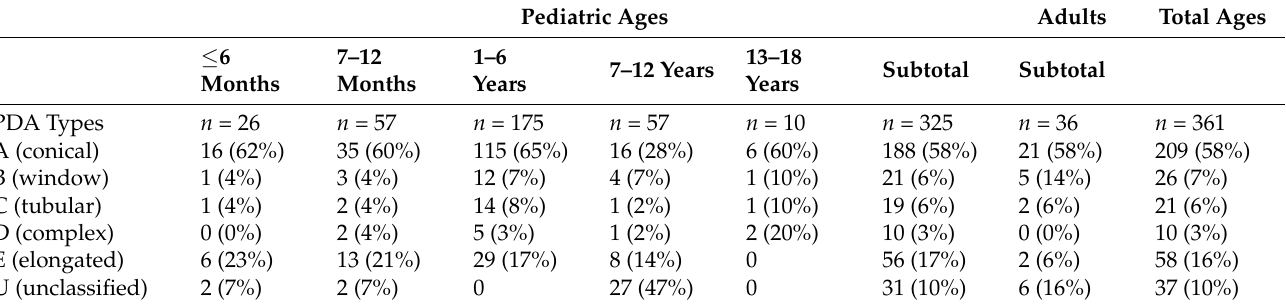
Table 3. Morphological types and numbers ( n ) of PDA subjects according to the chronological age groups.